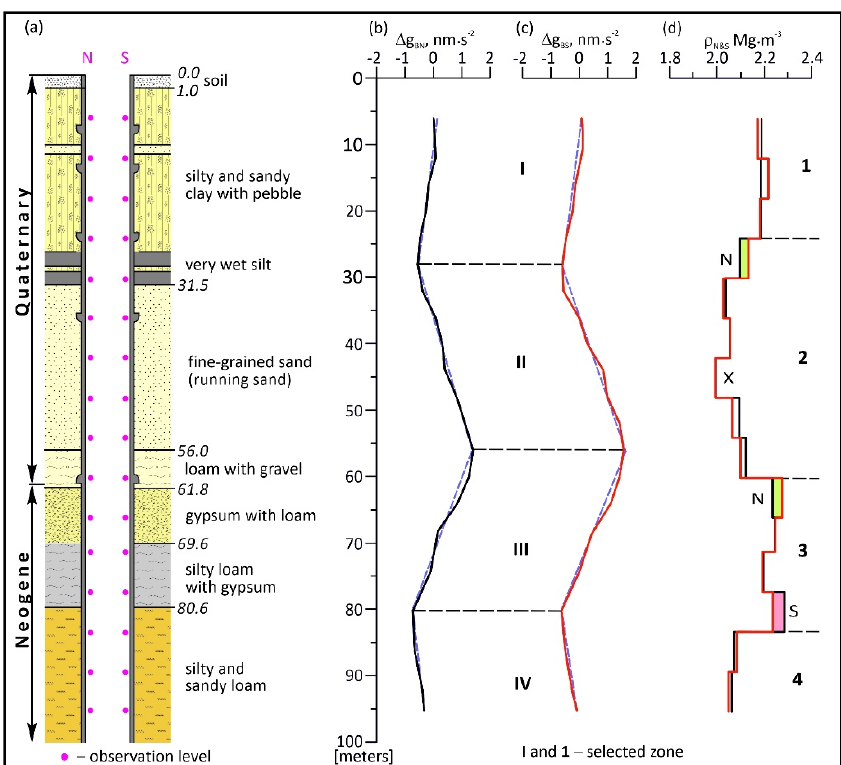
Figure 6. The results of vertical gravity profiling: ( a ) lithology, ( b ) and ( c ) “Bouguer anomaly”, ( d ) densigram.